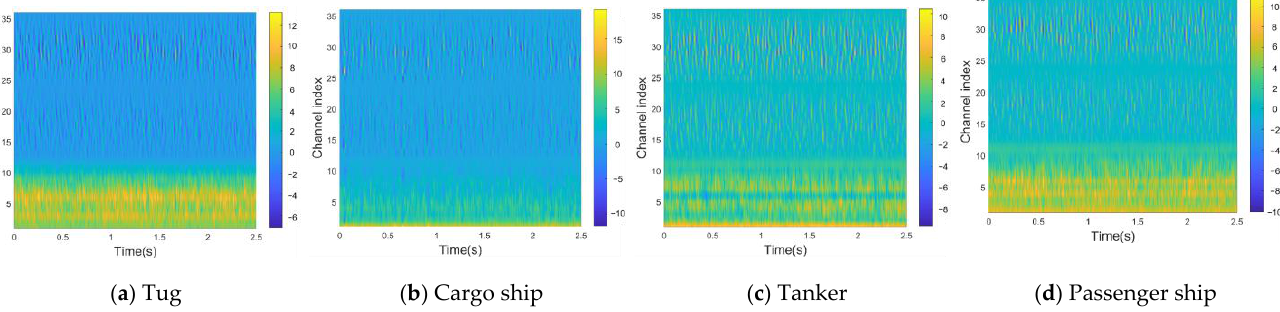
Figure 9. MFCC features of different types of ships.